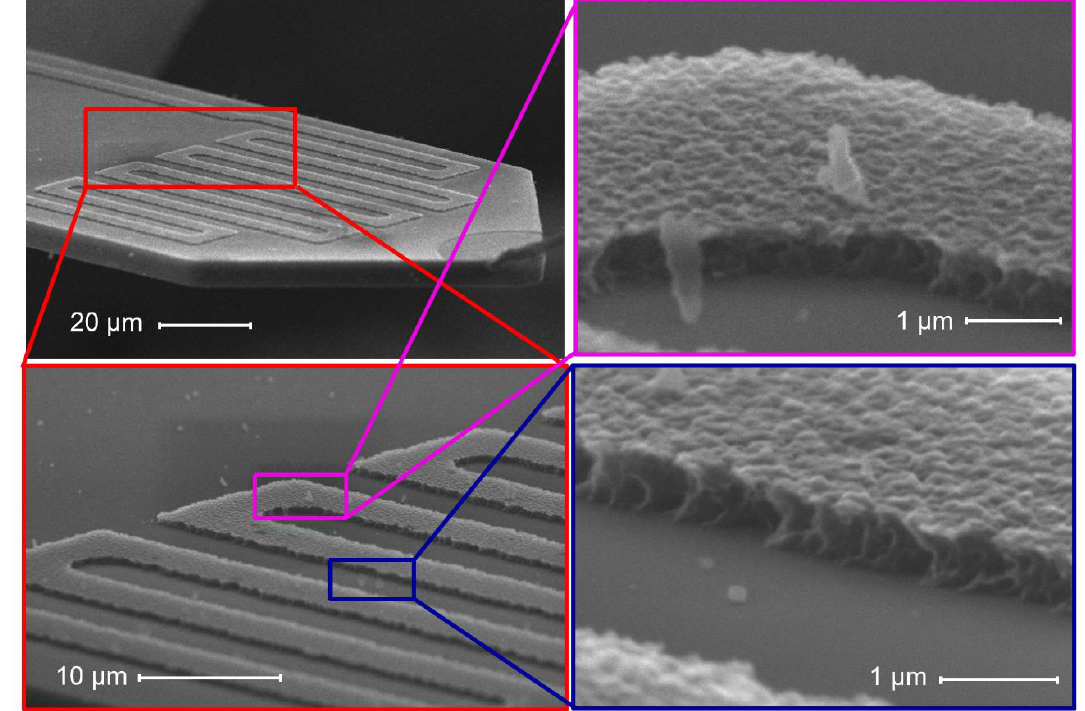
Figure 16. Surface morphology of the sampling area of the AFM-MCS cantilever after carbon-particle exposure. Particles deposited on the rough surface of the meander resistor are hardly detectable, while few particles were trapped around it.